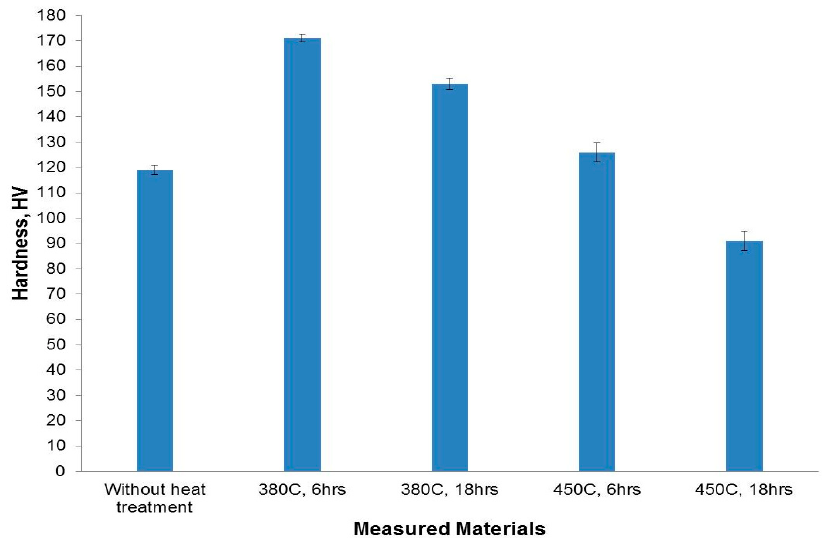
Figure 12. Average hardness measurement values of the formed composites of 6% Cu together with samples heat treated at different temperatures and times.